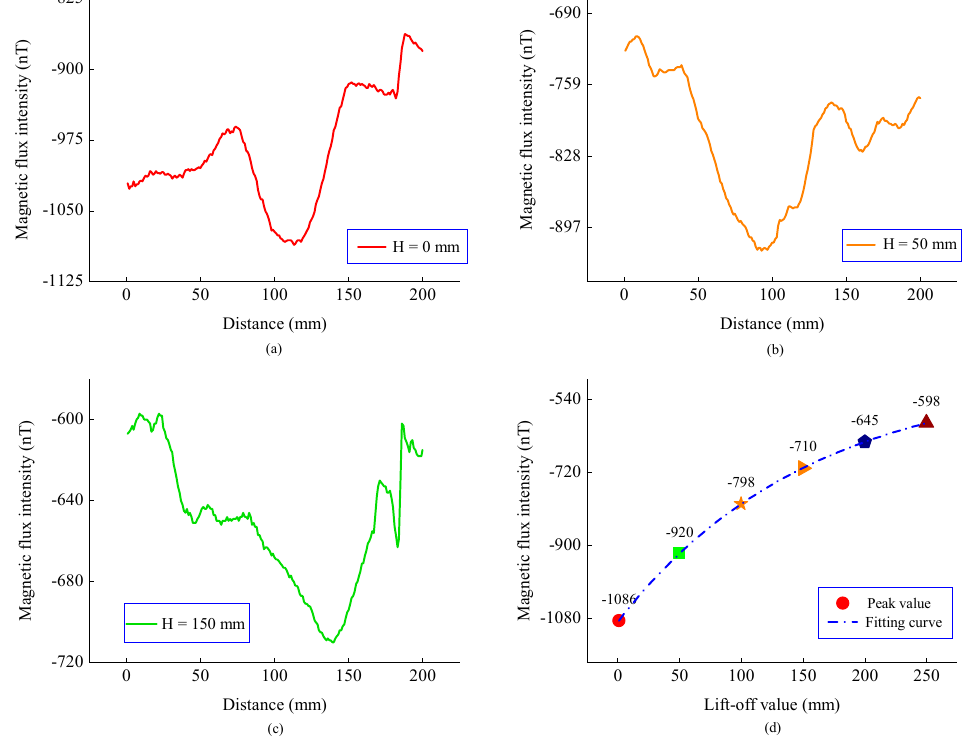
Figure 14. Tangential components and the peak curve of the magnetic flux intensity at different lift-offs. ( a ) Normal components when H is 0 mm. ( b ) Normal components when H is 50 mm. ( c ) Normal components when H is 150 mm. ( d ) Peak and fitting curve.